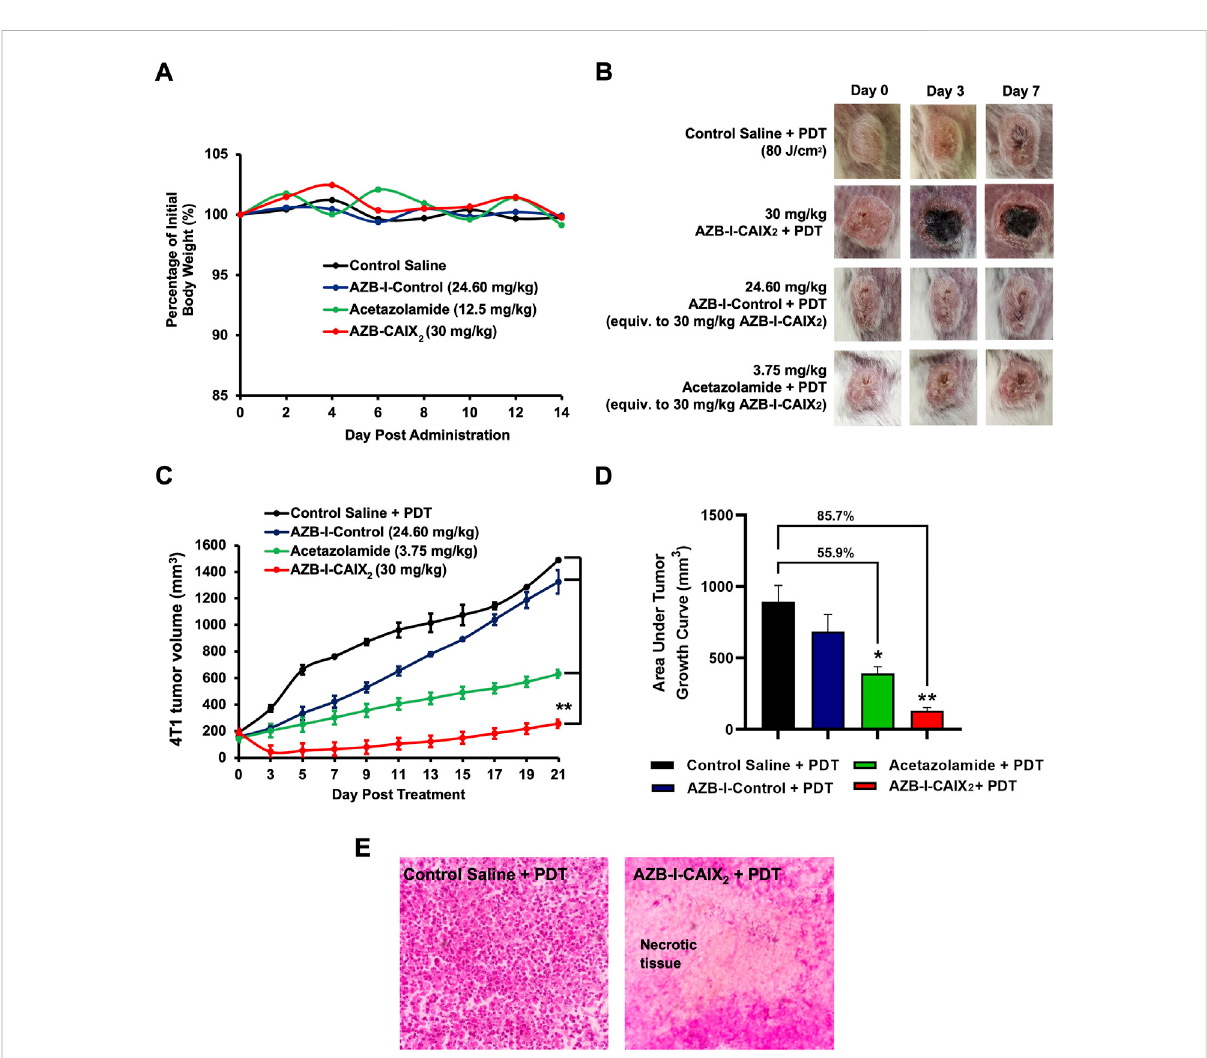
FIGURE 8 Invivo acutetoxicityandantitumoref fi cacyofAZB-I-CAIX (A) Percentageofmicebody 2 ,AZB-I-Control,andacetazolamidewithoutirradiation. weight ( n = 2) for in vivo acute toxicity study throughout 14 days of observation. (B) Gross observation of tumor at days 0, 3, and 7 post-PDT. The fi gureineachgroupisrepresentativeof n =6mice. (C) 4T1tumorvolumepost-AZB-I-CAIX 2 ,AZB-I-Controlandacetazolamidetreatment,andPDT. ** p < 0.0001 for AZB-I-CAIX 2 vs control saline, AZB-I-Control, and acetazolamide at all time points. (D) The area under the tumor volume in AZB-I-CAIX 2 , AZB-I-Control, and acetazolamide throughout 21 days of analysis. The graph represents mean ± SEM ( n = 6), * p < 0.001 and ** p < 0.0001 compared to control saline, using One Way ANOVA (Dunnett ’ s). (E) H&E histological analysis of 4T1 tumor tissue post-three days of PDT. (Left) Control saline and PDT. (Right) 30 mg/kg AZB-I-CAIX2 and PDT with necrotic tissue. The picture shown is a representative of each group with similar results. Magni fi cation: